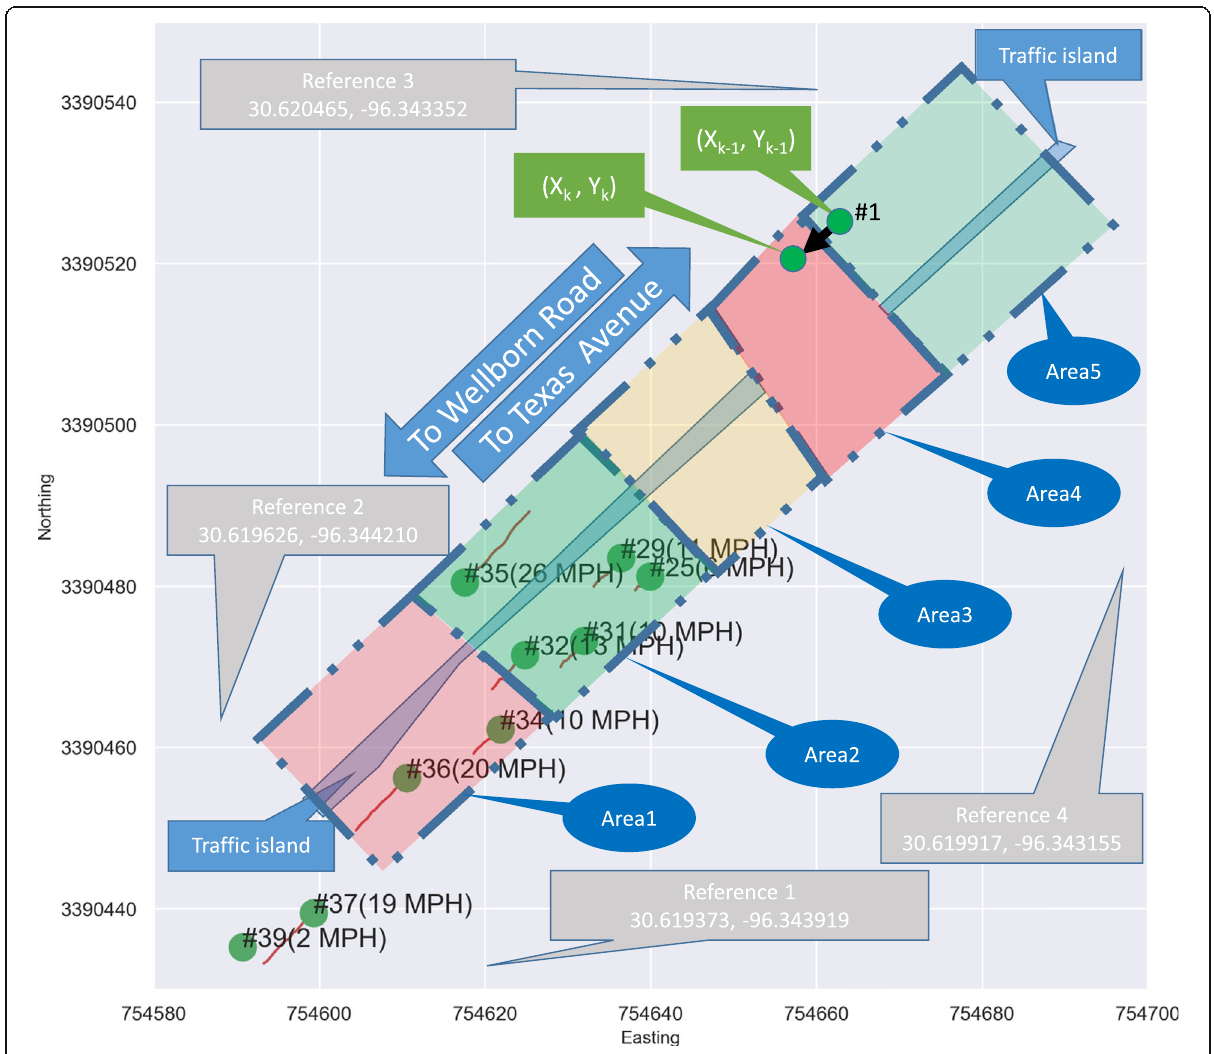
Fig. 4 Reference points, Areas 1 through 5, and traffic projection on UTM map. Each circle represents the projected vehicle. The line connected to the circle indicates its trace in the last second, which is used to compute the mile per hour (MPH) next to the ID